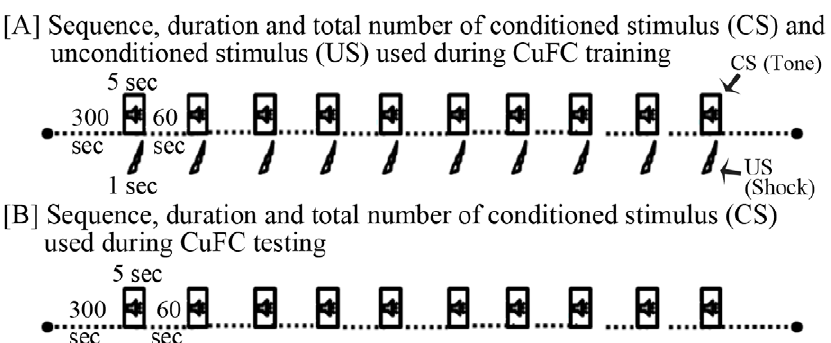
Figure 1. Cued fear-conditioning protocol. (A) Ten paired conditioned (tone: 2200 Hz, 90 dB) and unconditioned (foot-shock: 0.8 mA AC current) stimuli were presented over a period of 1200 sec for fear conditioning. Tones were presented at an interval of 60 sec for 5 sec which co- terminated with 1 sec foot-shock. (B) Animals were tested for cued fear-conditioning the next day, during which only conditioned stimulus (tone) of similar sequence, duration and number (as used during cued fear-conditioned (CuFC) training) was